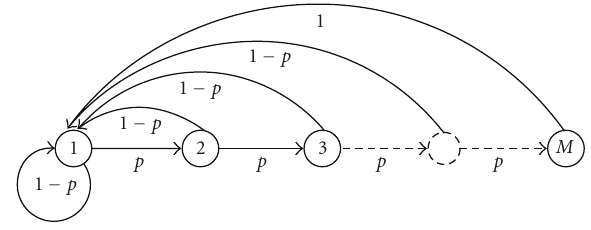
Figure 2: The retransmission model where p = 1 − P s ( e x